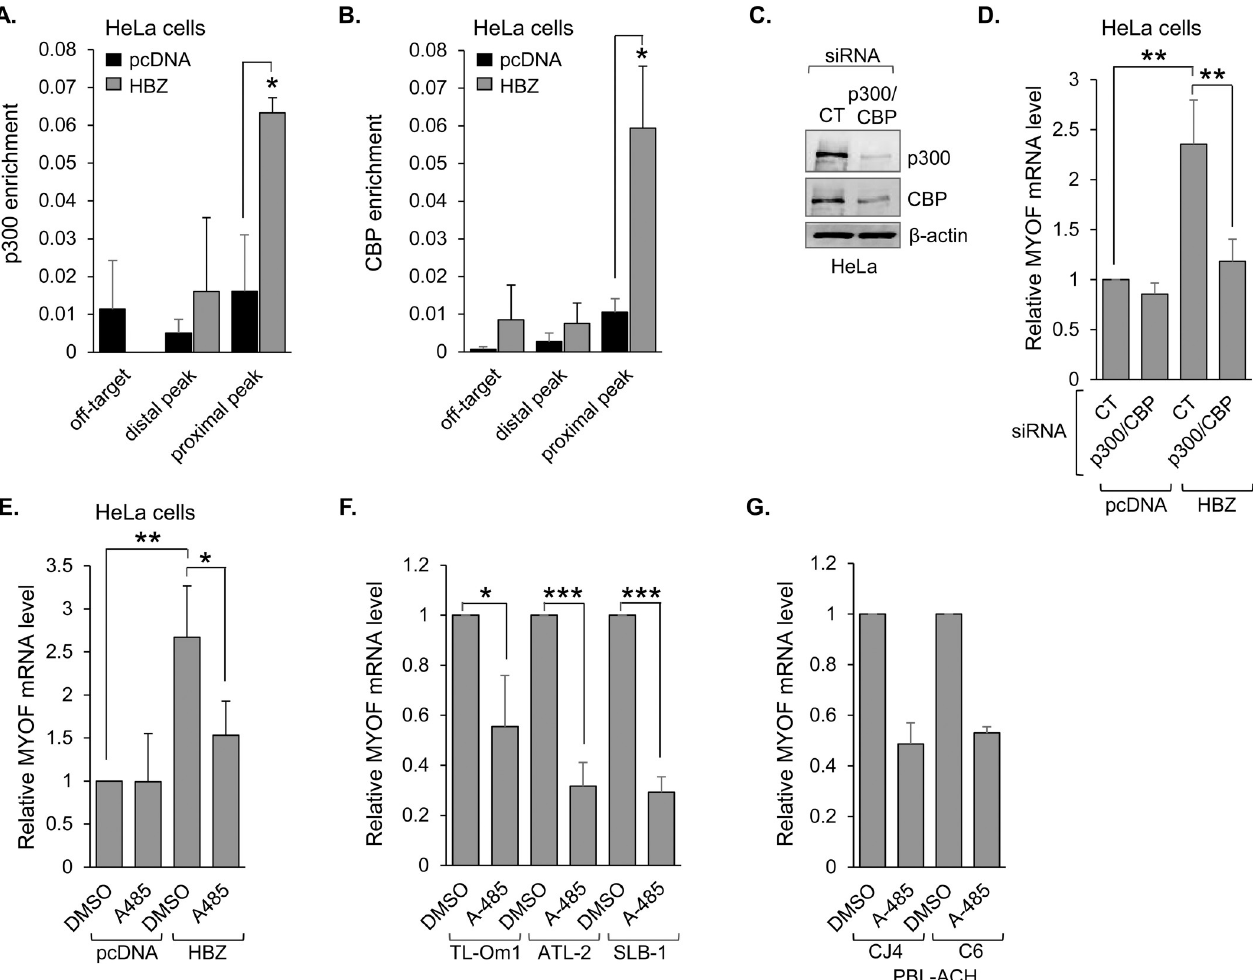
Fig 4. HBZ activates MYOF transcription through recruitment of p300/CBP. p300 (A) and CBP (B) bind the proximal MYOF peak in HeLa cells expressing HBZ. Graphs show average values from three independent ChIP assays using empty vector (pcDNA) and HBZ-expressing HeLa cells. Shown are levels of p300- and CBP-enrichment at the off-target site and at the distal and proximal peaks; � p < 0.05. (C) siRNA-mediated depletion of p300 and CBP. HeLa cells were transfected with siRNAs targeting both p300 and CBP (p300/CBP) or an off-target siRNA (CT). Whole cell extracts (50 μ g) were analyzed by Western blot using antibodies against p300, CBP and β -actin. (D) Depletion of p300 and CBP reduces HBZ-mediated MYOF expression. The graph shows qRT-PCR results averaged from four independent experiments with values normalized to those for the empty-vector clone (pcDNA) transfected with siRNA CT (set to 1); �� p < 0.01. (E) Inhibition of p300/CBP KAT activity abrogates HBZ-mediated activation of MYOF transcription. HeLa cells expressing HBZ or carrying the empty vector (pcDNA) were treated with A485 (10 μ M) or the carrier (DMSO) for 3h. The graph shows qRT-PCR results averaged from four independent experiments with values normalized to those for the empty-vector clone (pcDNA) treated with DMSO (set to 1); � p < 0.05, �� p < 0.01. Inhibition of p300/CBP KAT activity reduces MYOF transcription in (F) HTLV-1 infected T-cell lines (TL-Om1, ATL-2 and SLB-1) and (G) HTLV-1-immortalized primary human T- cell clones (CJ4 and C6). The indicated cell lines/clones were treated with A485 (10 μ M) or the carrier (DMSO) for 3h. Graphs show qRT-PCR results averaged from three (F) and two (G) independent experiments with A485 values normalized to those for DMSO (set to 1) for each cell line/clone; � p < 0.05, ��� p < 0.001.